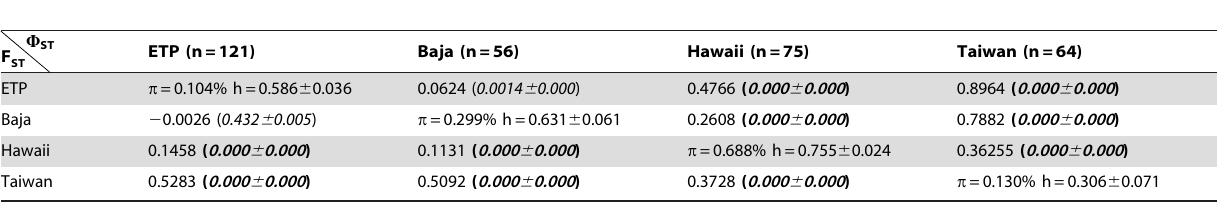
Table 2. Pairwise Fst (below diagonal) and W st (above diagonal) values for the COI gene from the Pacific Ocean populations of Alopias pelagicus